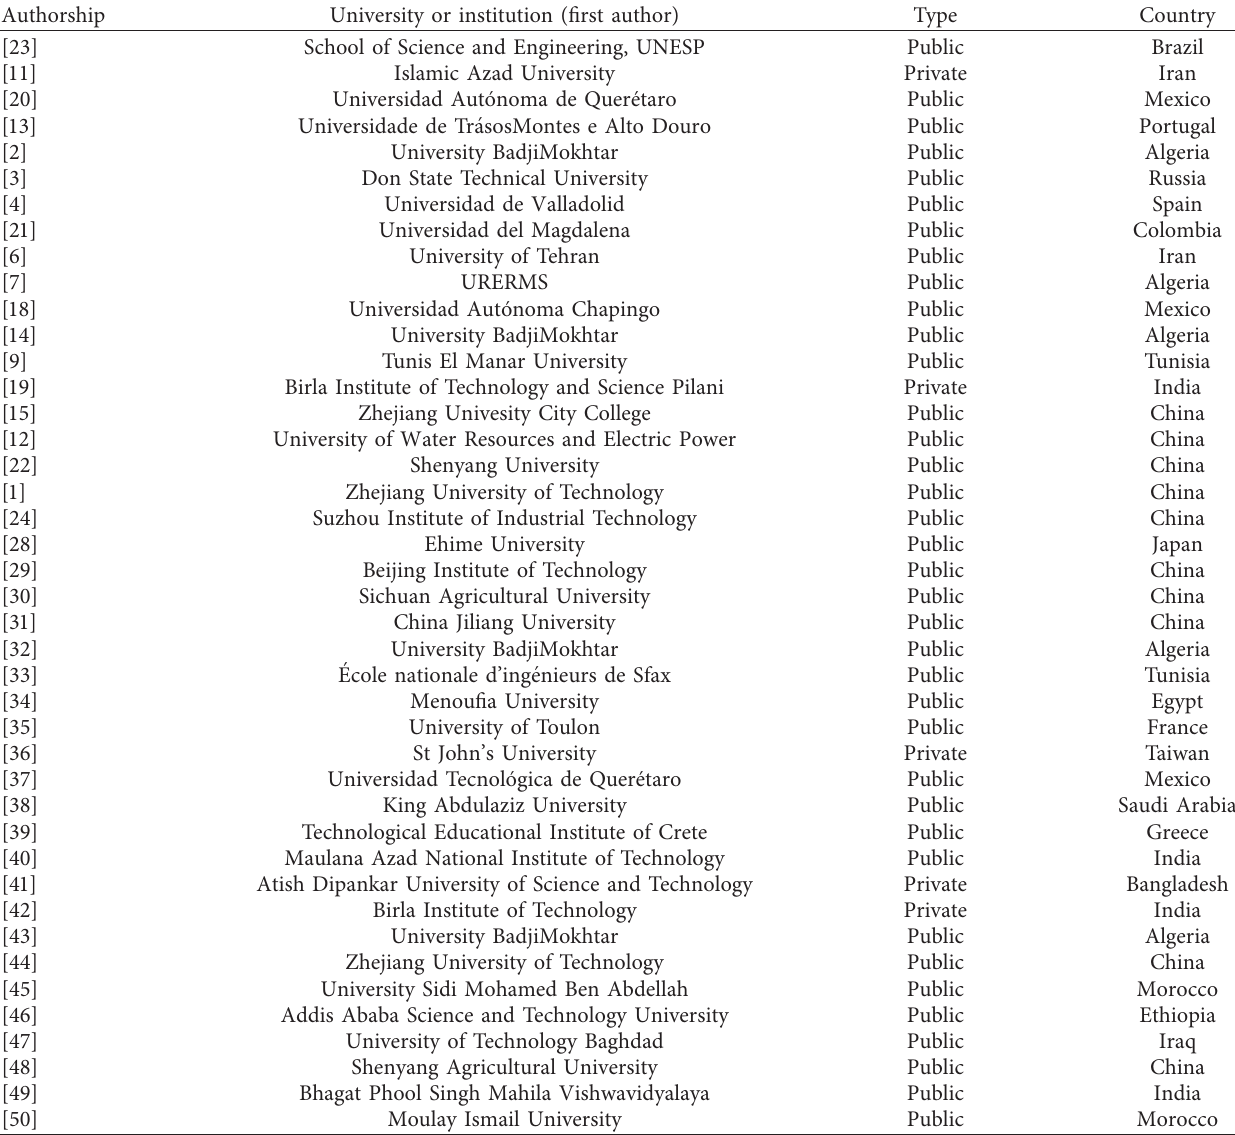
Table 2: Details of the institution promoting the